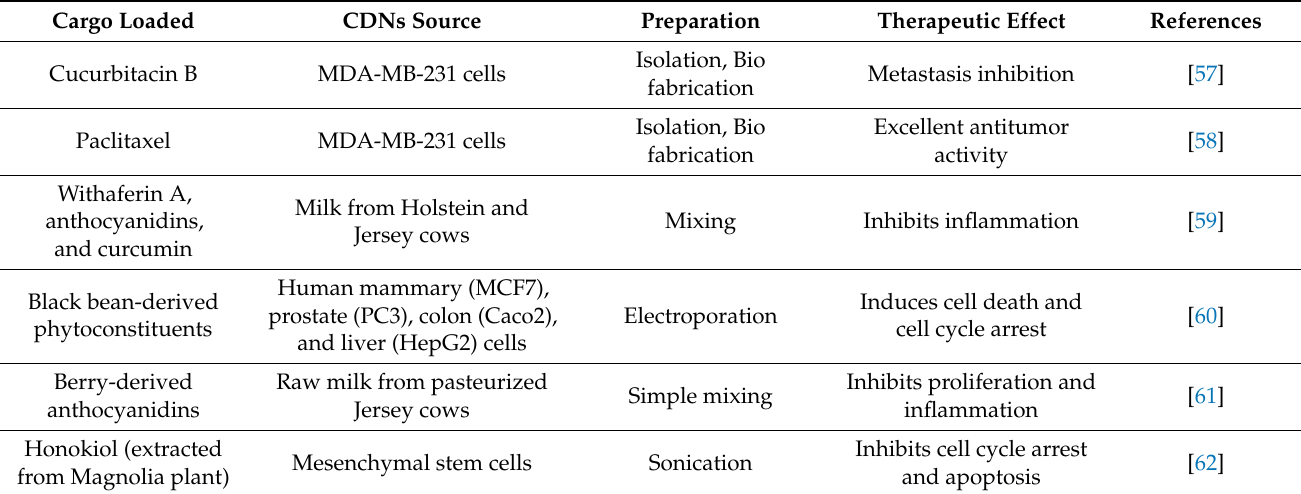
Table 1. List of the reported CDNs with phytochemicals for breast cancer